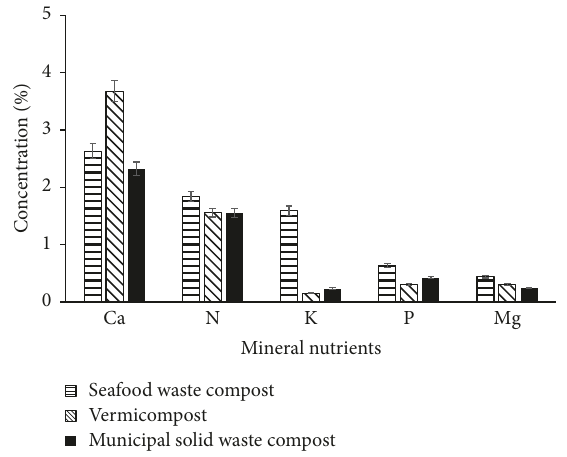
Figure 2: Macronutrients composition in seafood waste compost, vermicompost, and municipal solid waste compost. Calcium (Ca);